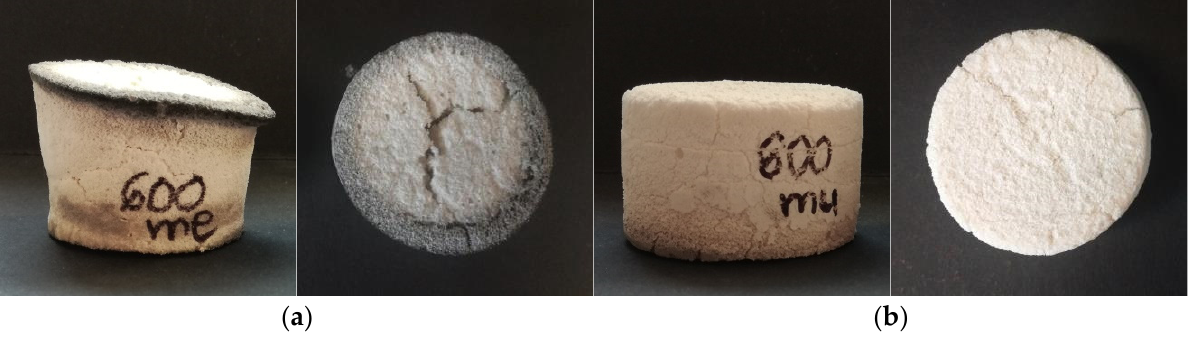
Figure 8. ( a ) Unwashed and ( b ) washed samples after firing. (The left side of the subfigures shows the given sample from a side view, and the right side shows a top view of the same sample.)